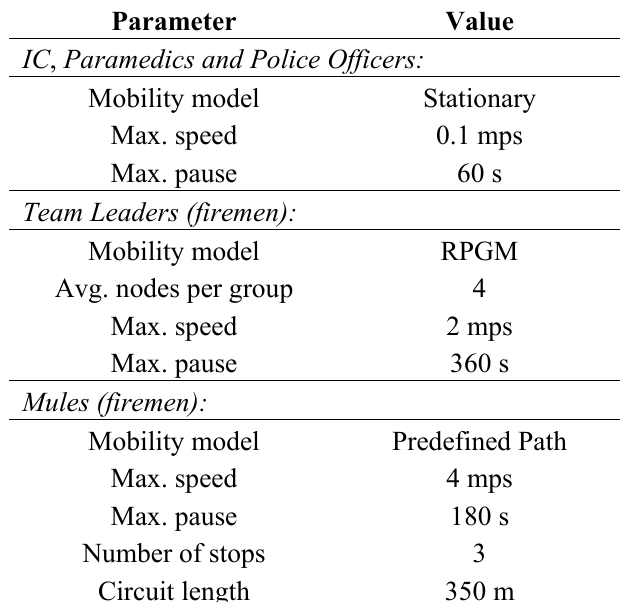
Table 2. Parameters of the mobility models for each node type.